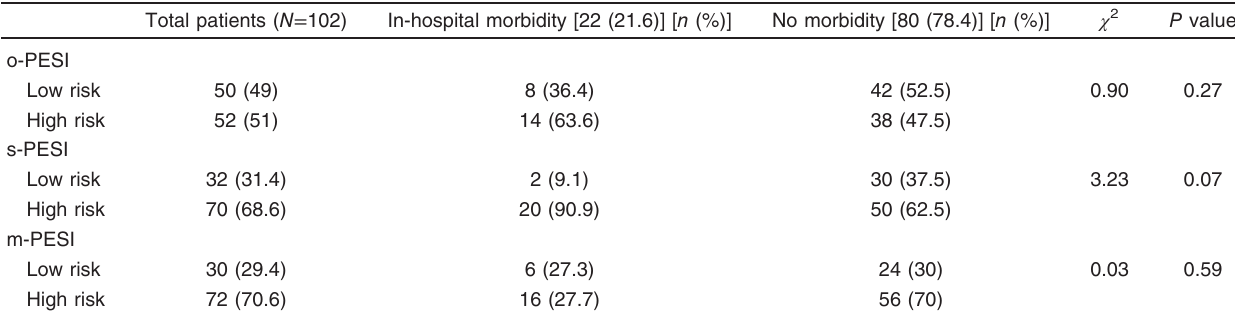
Table 4 Frequency of homeostatic morbidity according to risk stratification of the studied scores Total patients ( N = 102)